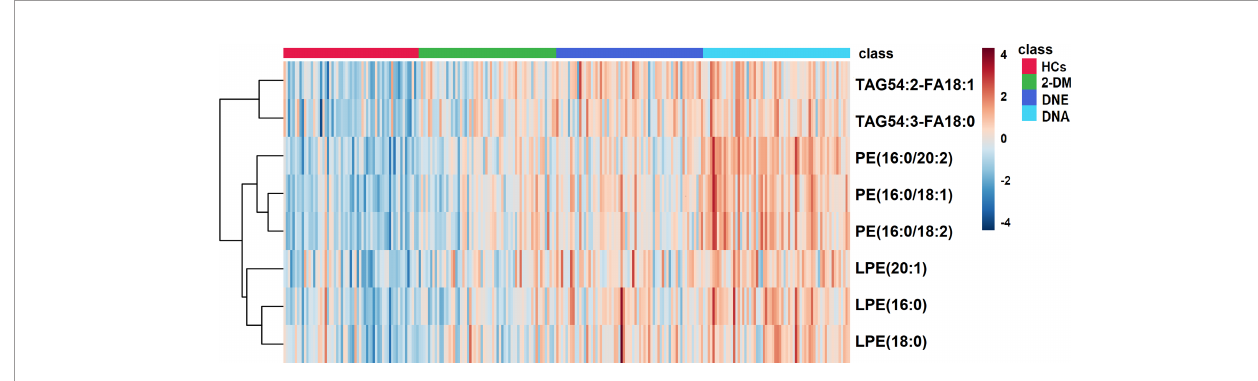
FIGURE 4 | A Heatmap of the differential metabolites in HCs, 2-DM, DNE and DNA. Rows: serum samples; Columns: lipid species.